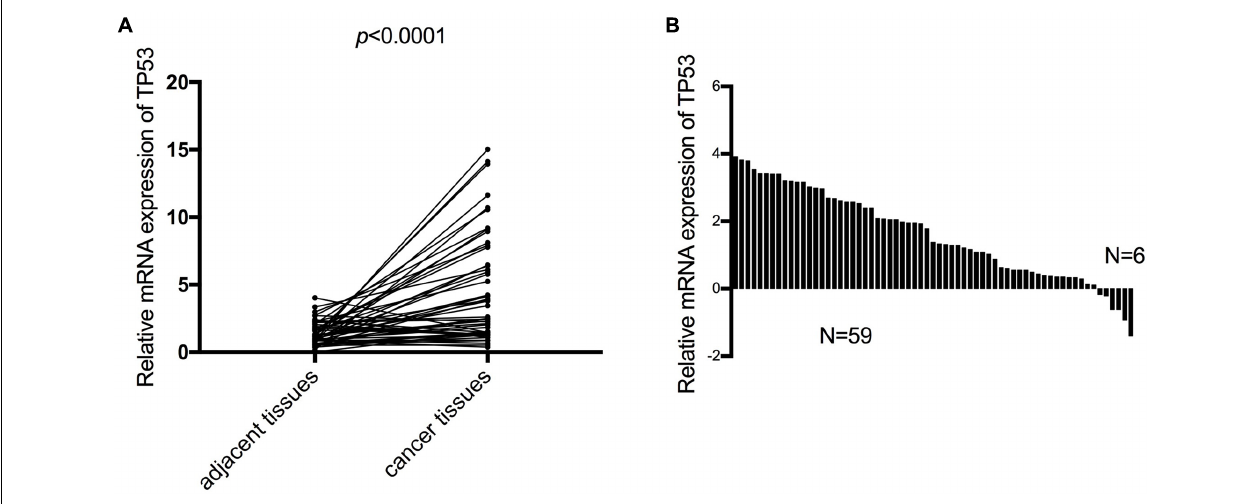
FIGURE 5 | The mRNA expression of TP53 validated in 65 patients with ESCC. The mRNA expression of TP53 and the matched adjacent tissues detected by qRT-PCR. Three independent experiments were conducted (A) . High mRNA expression of TP53 more than 90% (59/65) of ESCC tissues compared with adjacent normal tissues (B) .